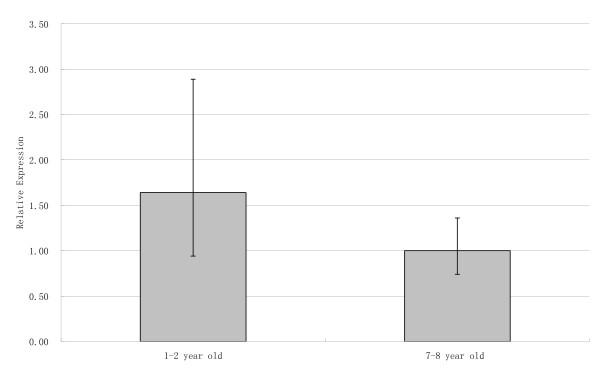
The relative expression levels of SCML1 in testis during male sexual maturation, which was tested using real time quantitative PCR. Two age groups were tested including the 1–2 year old macaque group and the 7–8 year old macaque group. Ten individuals were sampled for each group.